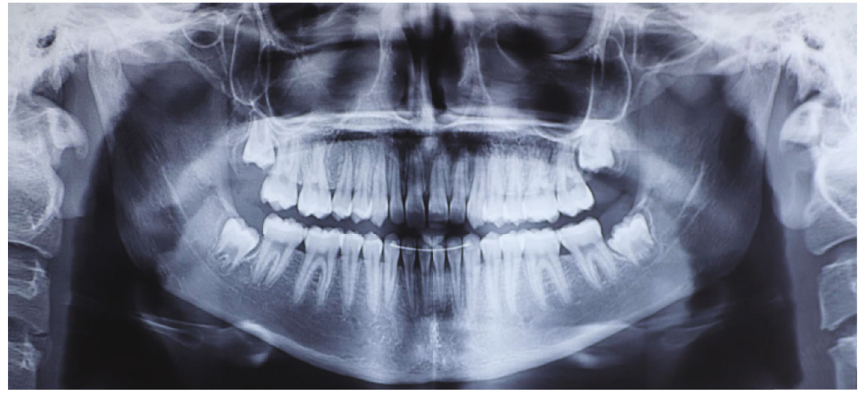
Figure 14: Final OPT.